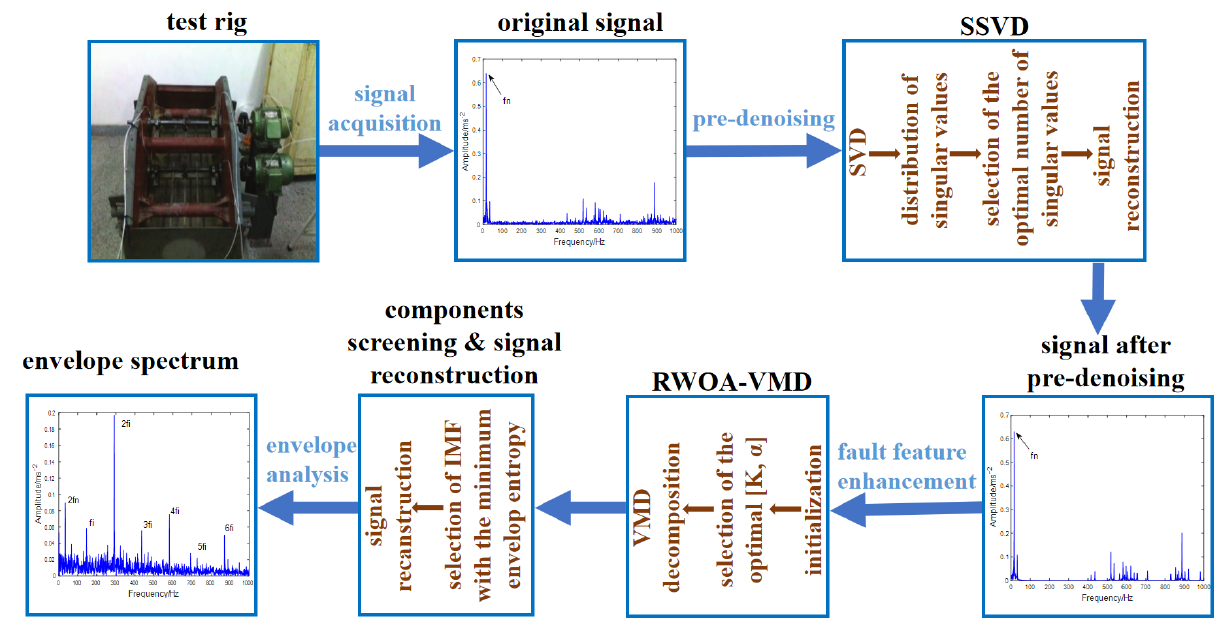
Figure 7. The flow chart of the method of combining SSVD and RWOA ‐ VMD for signal processing of vibrating screen exciter